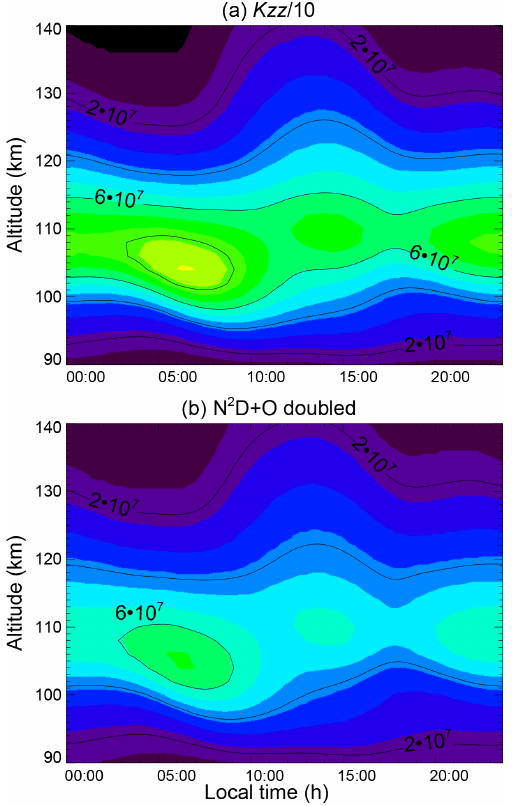
Figure 6. Diurnal variation of calculated nitric oxide at 4 ◦ S, both with the nudged model, but with the additional indicated changes to the TIME-GCM. The color scheme is the same as in Fig. 3